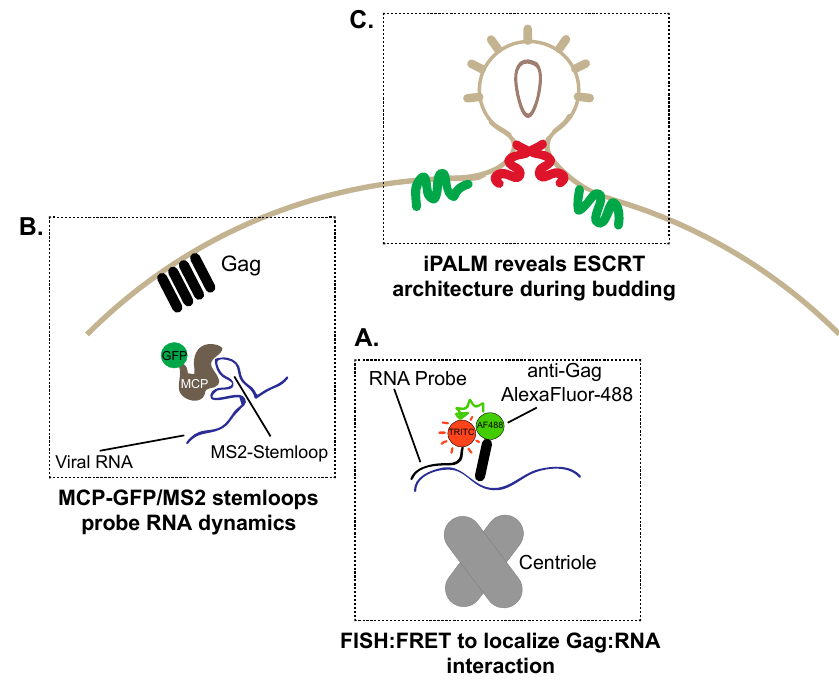
Figure 5. Tools to study HIV ‐ 1 assembly and budding. ( A ) Gag and viral RNA has been localized to the centriolar region by visualizing FRET between a FISH probe (tetramethylrhodamine (TRITC): Red ) targeted towards viral RNA and AlexaFluor ‐ 488 immunostained Gag ( Green ); ( B ) Gag multimers assemble on the plasma membrane prior to viral RNA localization. RNA dynamics can be visualized by exploiting the high affinity interaction between the major capsid protein (GFP ( Green )–major capsid protein (MCP; Brown )) and an MS2 bacteriophage stem ‐ loop engineered onto the HIV ‐ 1 genome ( C ) Super ‐ resolution interferometric photoactivation and localization microscopy (iPALM) imaging demonstrates how endosomal sorting complexes required for transport (ESCRT) proteins assemble around HIV ‐ 1 budding sites. Charged multivesicular body protein 2a/4b (CHMP2A/4B) ( Red and Green ) assemble within the neck of the budding virion to enable pinching of the plasma membrane to form single virions.